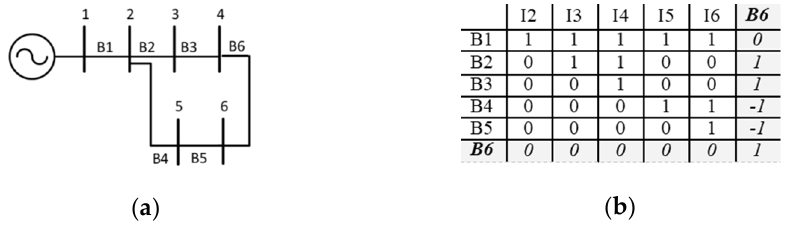
Figure 2. The 6-bus system mesh configuration ( a ) and BIBC matrix ( b ). Nonzero rows of B6 column give the information of branches which formed a loop. The branch to open, B op , should be selected from one of the branches B2, B3, B4, B5 or B6 itself to keep the system radial. Assuming Branch-4 is opened, B4 row should be equal to zero as in (6). In this case, B6 is equal to the sum of injection currents of buses 5 and 6 as in (7). BIBC matrix is updated with using (7). Branches those formed a loop are affected with added line. Opened branch, B4 , row of BIBC matrix become zero as in Figure 3b. Negative value on the B5 row indicates power flow direction is changed on 5th branch. Closed line B6 is replaced with opened one B4 on BIBC matrix and branch currents of reconfigured system as in Figure 3a are given in (8).